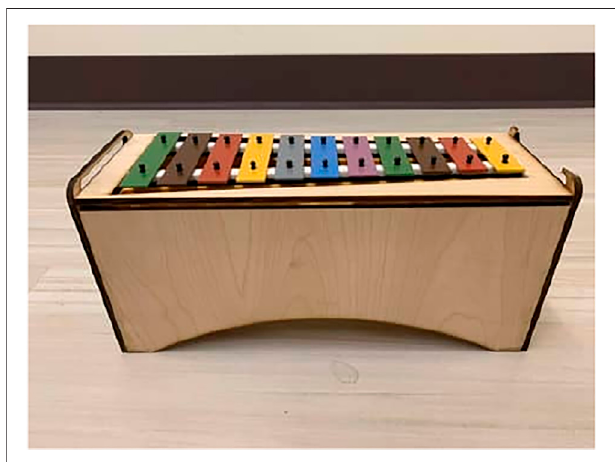
FIGURE 2 | Instrument stand front